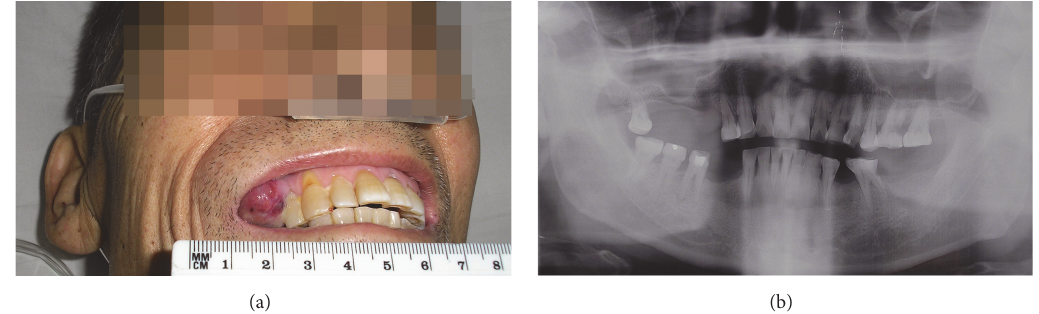
Figure 2: The gingival tumor and jawbone images. (a) A reddish gingival tumor of soft texture, clear margin, and central mucosal ulceration on the right upper maxillary. (b) Radiography without local bony destruction.